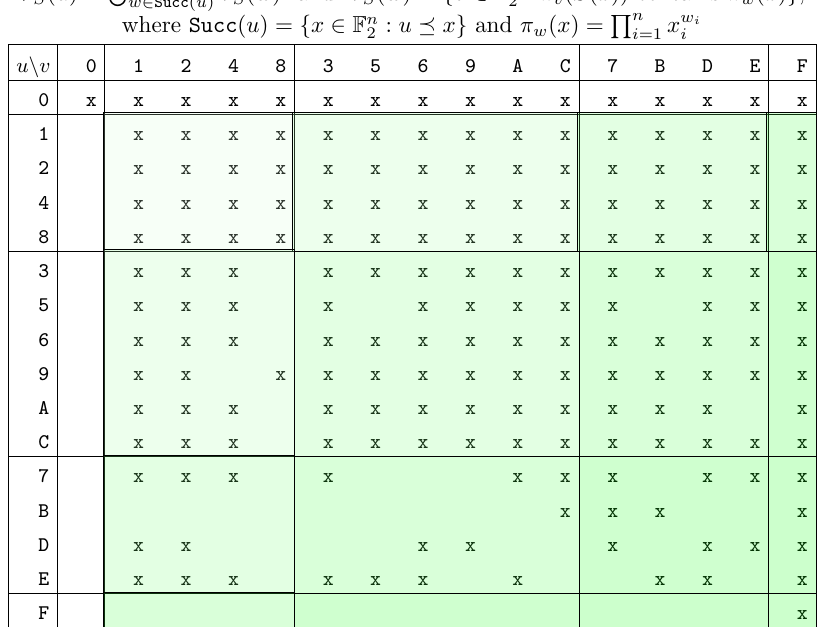
Figure 5: The table representation of V S ( u ) for all u ∈ F n